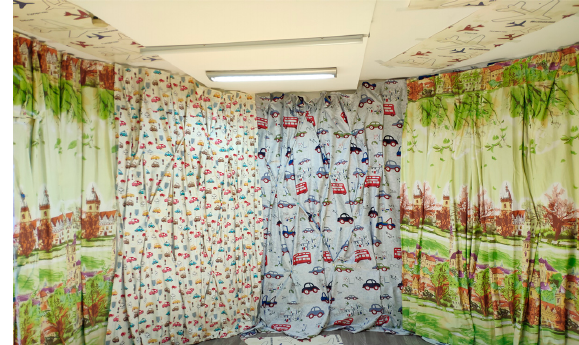
Figure 6. The real scene.